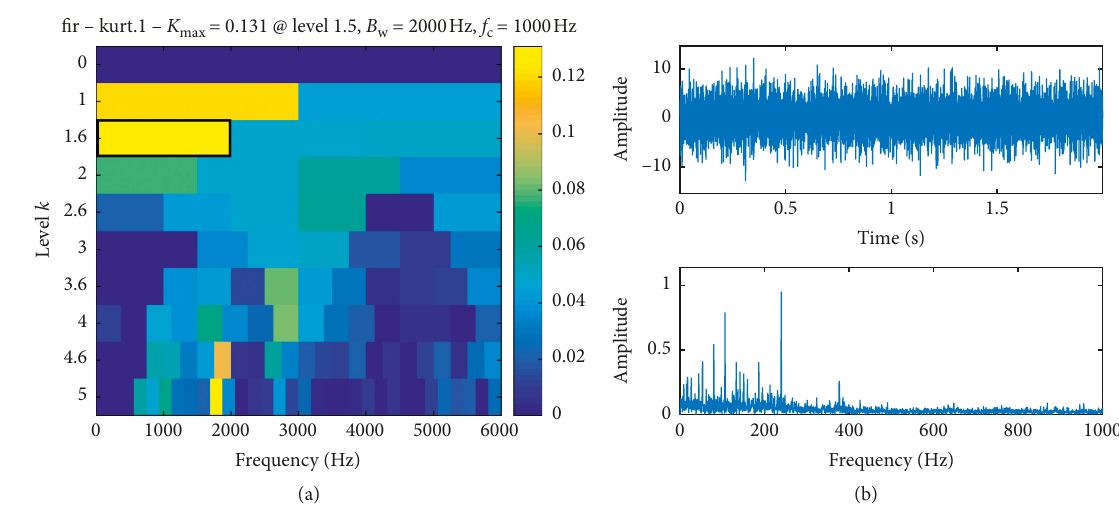
Figure 16: (a) Fast kurtogram based on FIR; (b) signal component and its envelope